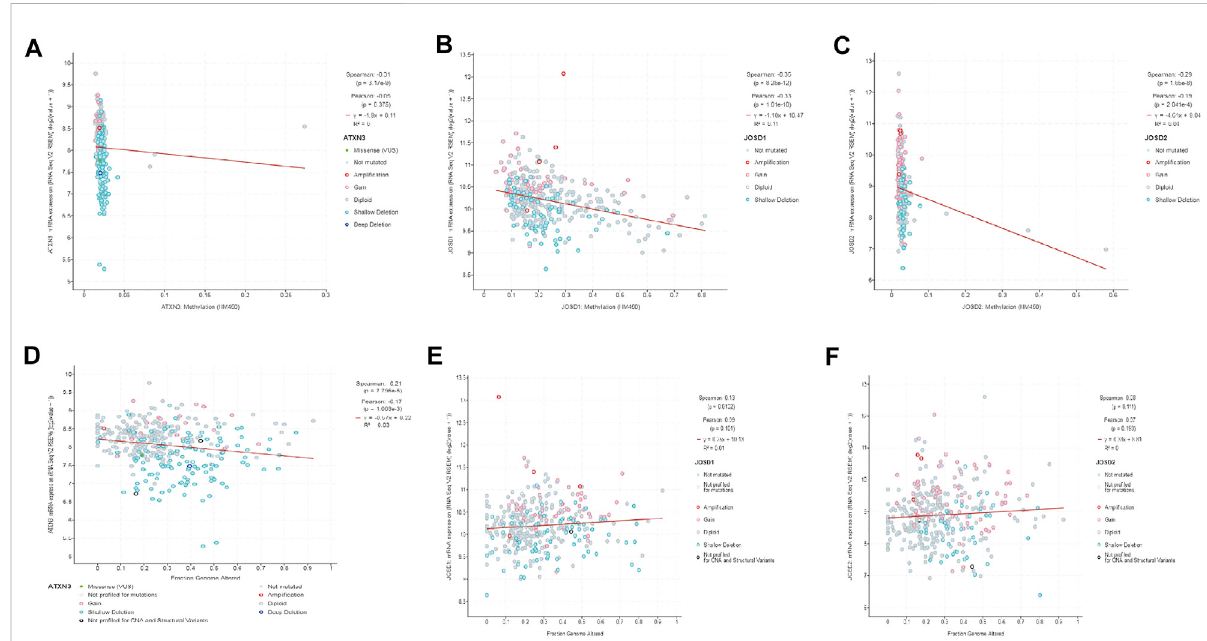
FIGURE 4 (A – C) The promoter methylation levels of MJDs family members were inversely correlated with the expression of MJDs family members (D) ATXN3 mRNA expression levels were positively associated to the fraction of the genome altered (E,F) The expressions of JOSD1 and JOSD2 were negatively related to the fraction of the genome